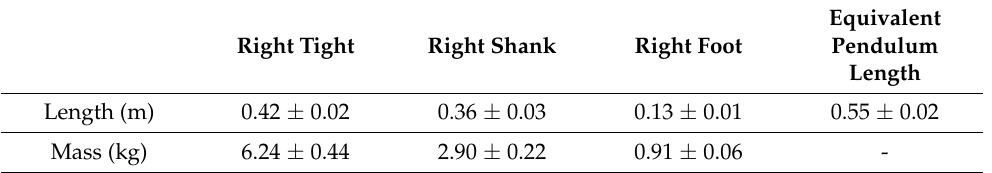
Table 1. Anthropometric measurements of the participants and equivalent pendulum length (mean and standard